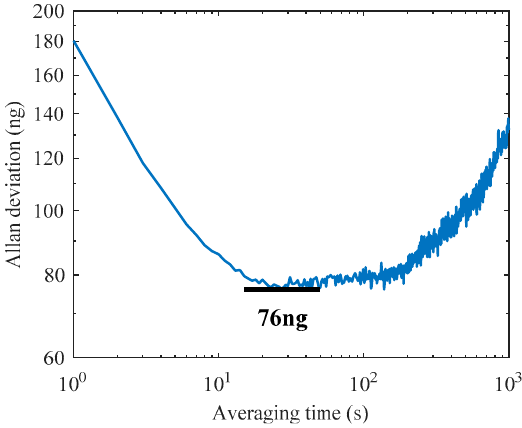
Figure 13. Allan deviation measurement of prototype A1.